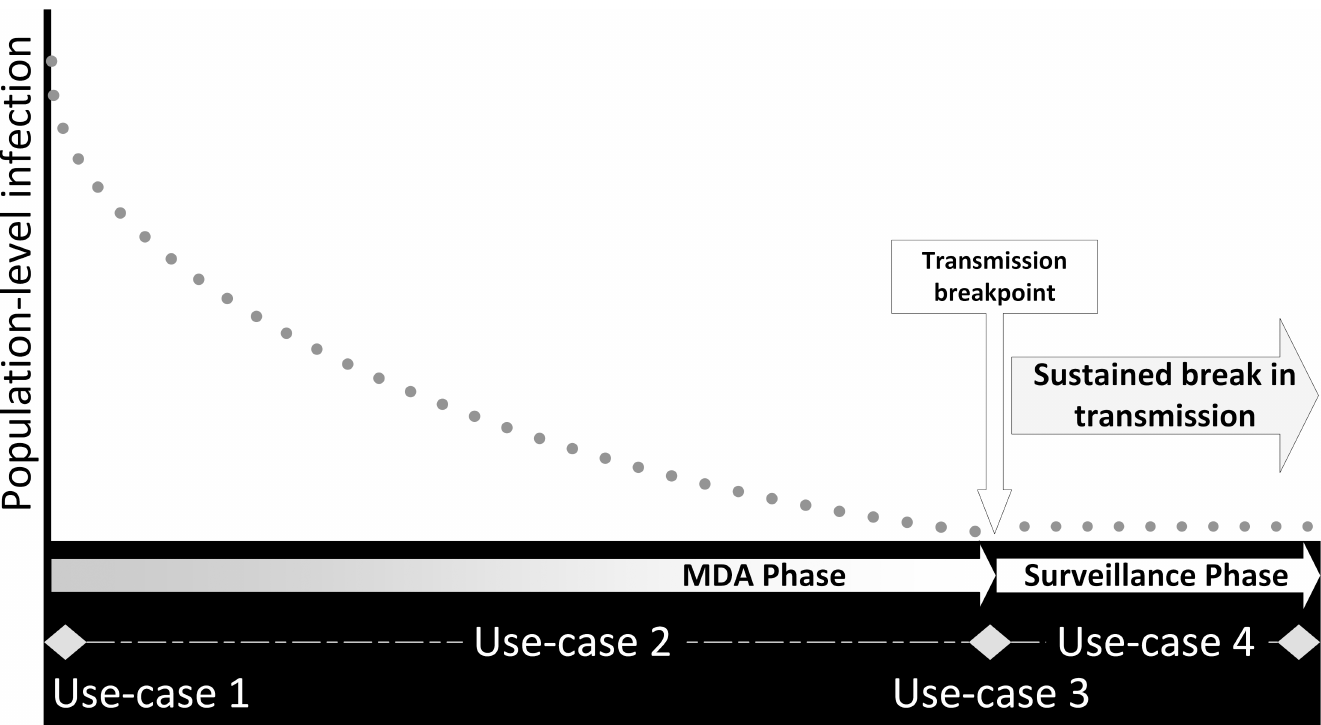
Fig 1. Hypothetical prevalence curve (dots) for a successful STH elimination program, overlaid with program phase (diamond for transition points) and diagnostic use-cases. MDA, mass drug administration; STH, soil-transmitted helminth.